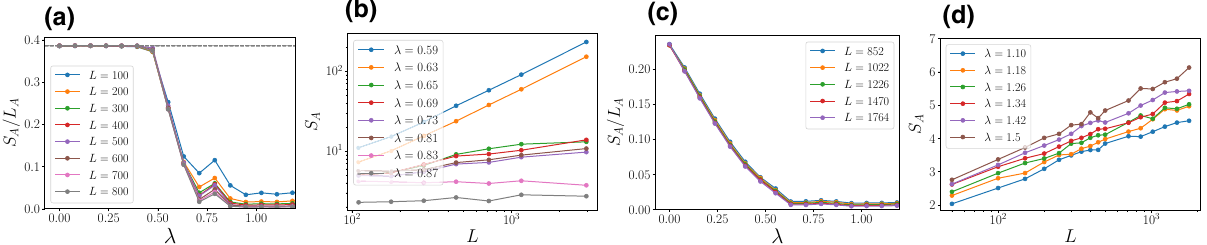
FIG. 2. Entanglement entropy S A of long-time-evolved states [evolution time up to O ( L 2 ) ] at the subsystem size fraction L A / L = 1 / 2. (a) Entanglement for the Floquet circuit, Eq. (4). The dashed gray line marks the entanglement entropy density averaged over all eigenstates of random quadratic Hamiltonians [80]. (b) Scaling of S A with L in a narrower range of λ for the same Floquet circuit as in (a). Here S A scales linearly with L (i.e., volume law) for λ (cid:2) 0.64 and follows an area law for λ (cid:3) 0.81. For 0.64 (cid:2) λ (cid:2) 0.81, S A ∼ O ( L γ ) with 0 < γ < 1. (c) Entanglement entropy density S A / L A for the spacetime-rotated nonunitary circuit in Eq. (5). Here S A / L A is nonzero for small modulation strength λ , while it vanishes for large λ . (d) Entanglement scaling in the regime 1.5 (cid:3) λ (cid:3) 1 for the same circuit as in (c). One finds that S A ∼ log ( L )